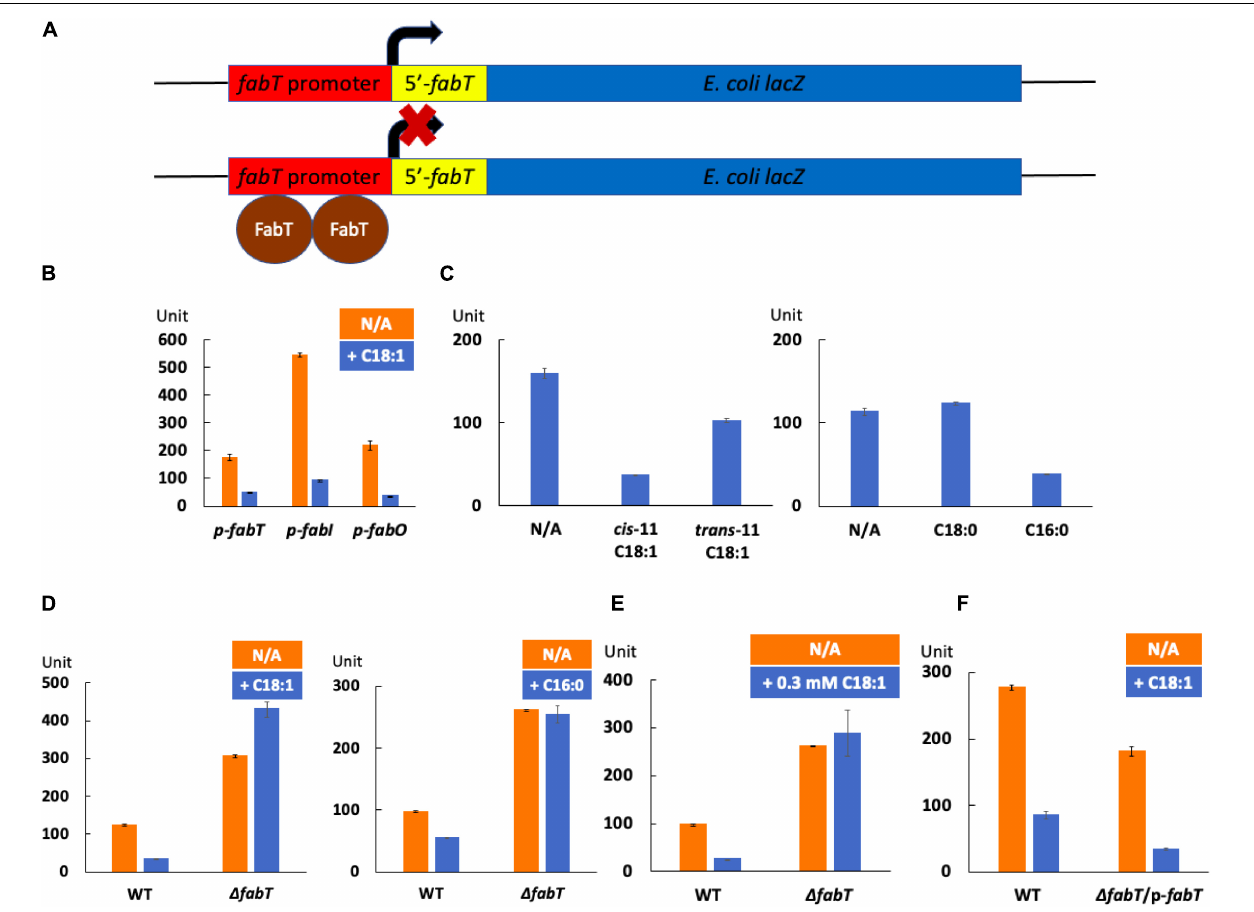
FIGURE 4 | Exogenous fatty acids enhance transcriptional repression by E. faecalis FabT. (A) The β -galactosidase reporter plasmid constructs. (B) The effects of oleic acid on expression of β -galactosidase driven by the E. faecalis fabT , fabI , or fabO promoter. (C) The effects of exogenous unsaturated fatty acids (at left) or saturated fatty acids (at right) on production of β -galactosidase driven by the E. faecalis fabT promoter. (D) The effects of oleic acid (at left) or palmitic acid (at right) on production of β -galactosidase by the fabT promoter in the E. faecalis (cid:49) fabT strain. (E) The effects of an increased concentration of oleic acid on production of β -galactosidase driven by the in E. faecalis fabT promoter in the (cid:49) fabT strain. (F) The effects of oleic acid on expression of lacZ gene from fabT promoter in E. faecalis (cid:49) fabT -complemented strain. The fatty acid concentration in the cultures was 0.1 mM for panels (B–D,F ). In Panel (E) the concentration was 0.3 mM.